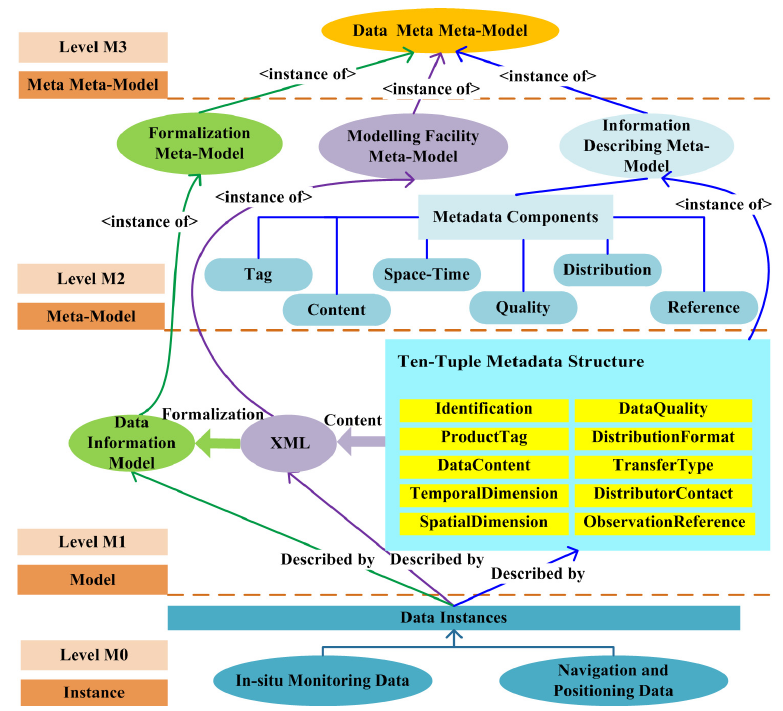
Figure 2. Spatio-temporal enhanced meta-modeling architecture.